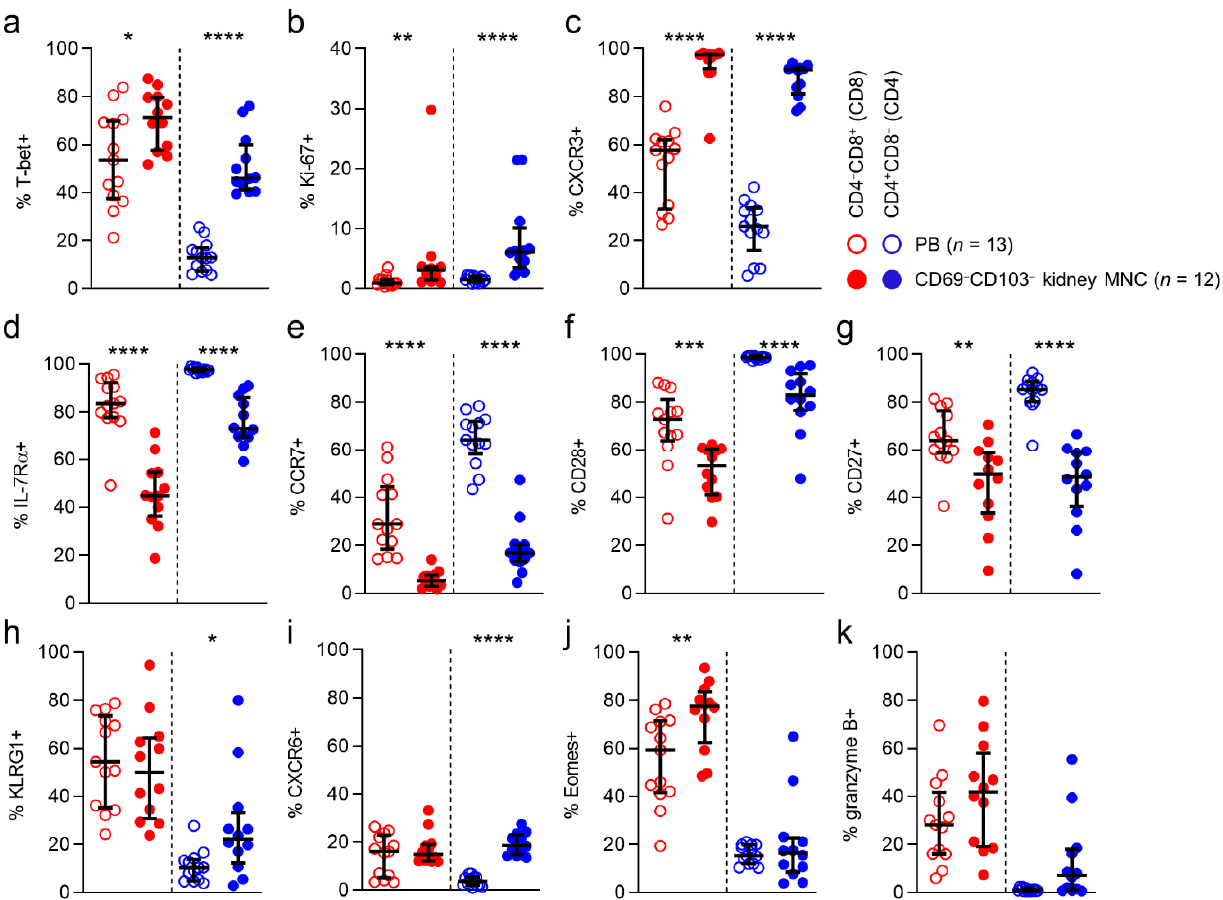
Figure 5. CD69 − CD103 − T cells in kidney tissue differ substantially from cells in the circulation. Comparison of Figure 5. CD69 ⁻ CD103 ⁻ T cells in kidney tissue differ substantially from cells in the circulation. expression of T-bet ( a ), ki-67 ( b ), CXCR3 ( c ), IL-7R α ( d ), CCR7 ( e ), CD28 ( f ), CD27 ( g ), KLRG1 ( h ), CXCR6 ( i ), Eomes ( j ) and granzyme B ( k ) in CD8 (red) and CD4 (blue) in peripheral blood (PB)-derived T cells and kidney-derived CD69 − CD103 − T cells (median with IQR in black). Mann-Whitney U-test was used for statistical comparison. Only significant p-values are displayed: * p < 0.05, ** p ≤ 0.01, *** p ≤ 0.001, **** p ≤